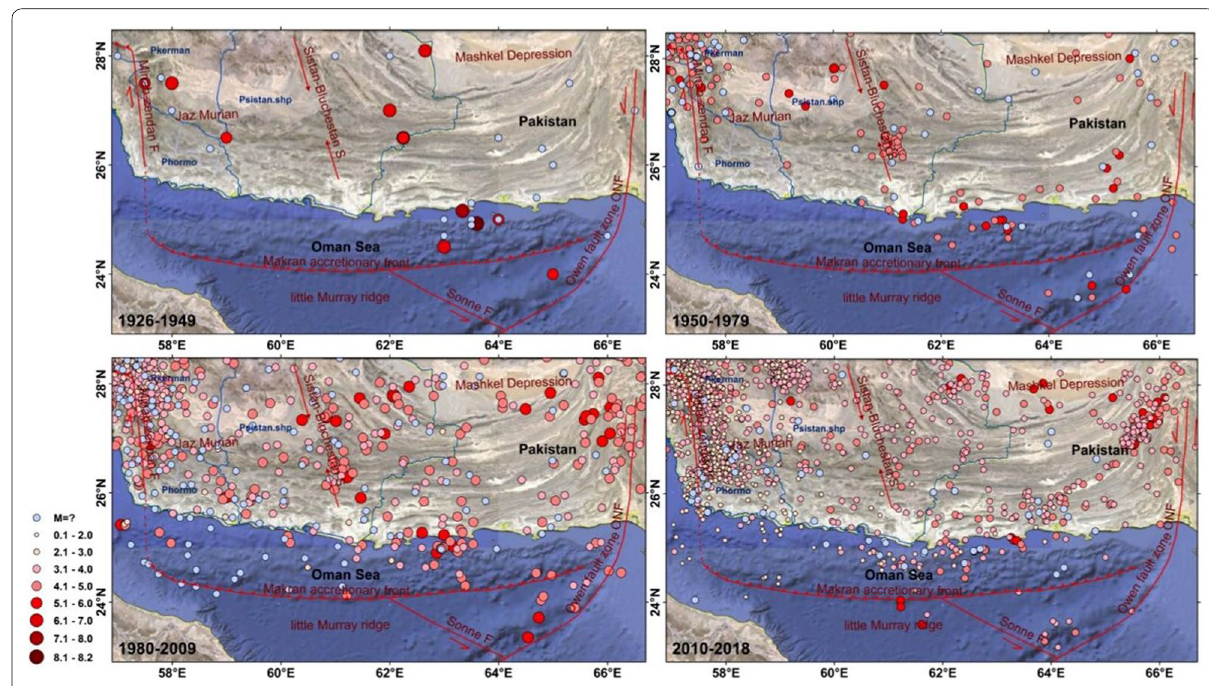
Fig. 2 The seismicity of Makran Subduction Zone from 1929 to 2018. The year range is defined at left bottom of map, and all magnitudes have been used for plotting. The sources of data are from ISC, bulletin at http://www.isc.ac.uk. Part of the main structural elements are also shown as the Sistan and Baluchestan Suture